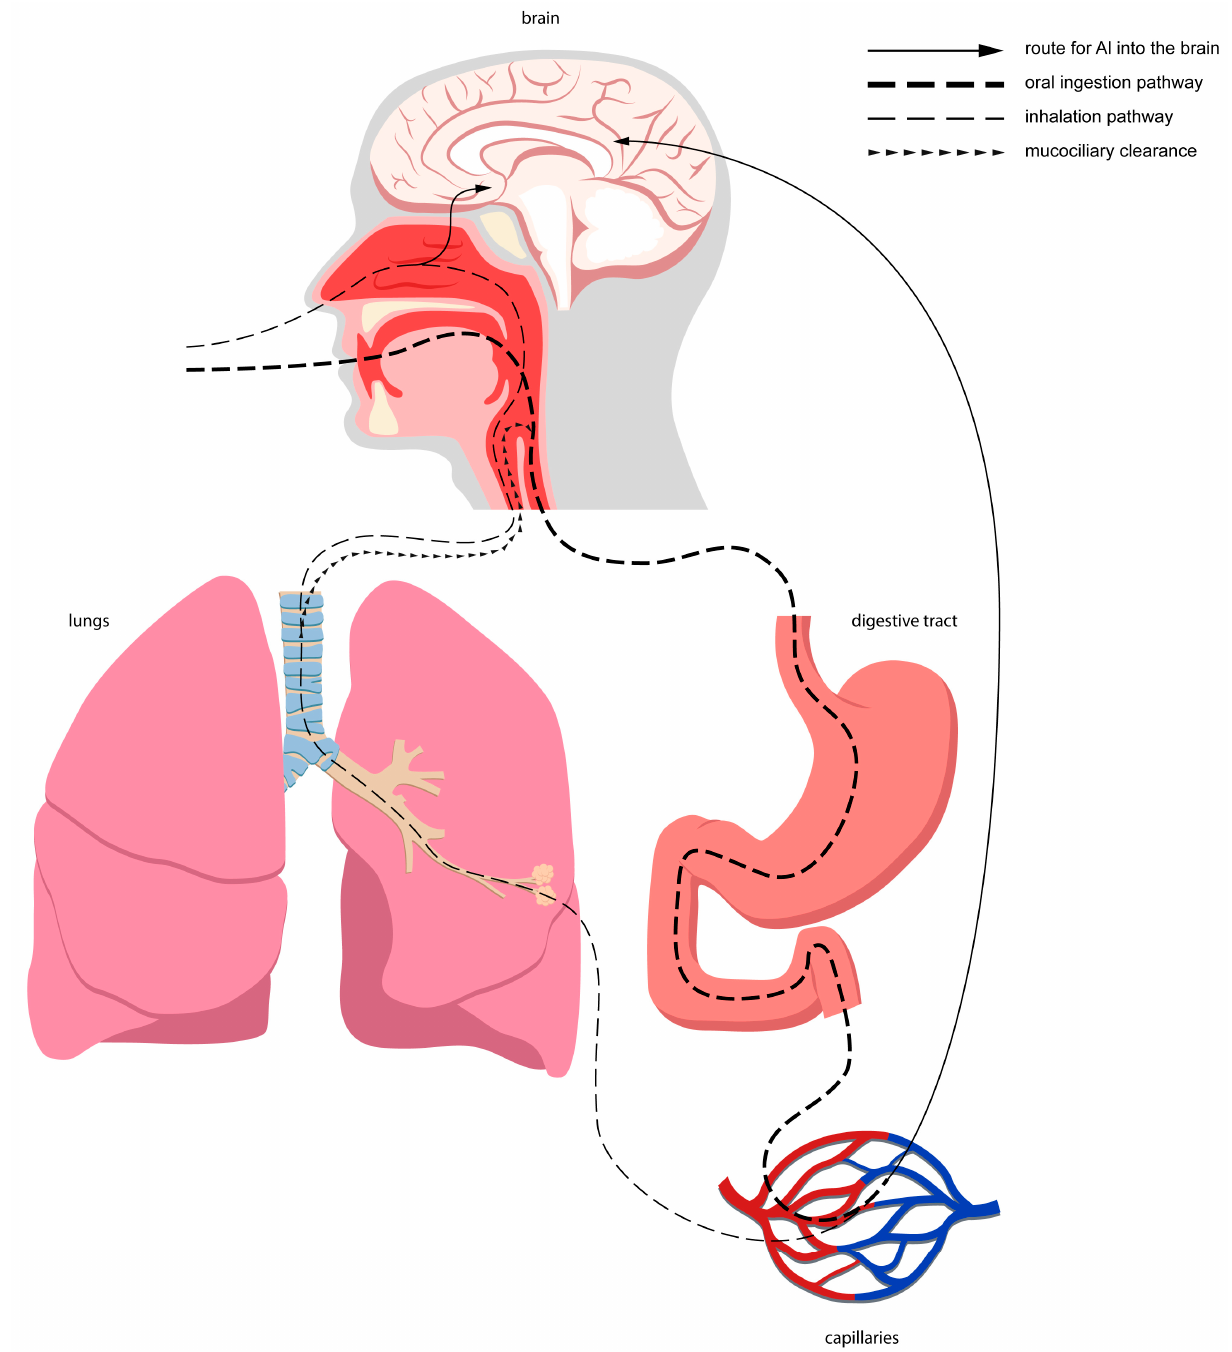
Figure 1. Main routes for Al into the brain. Red capillaries symbolize arterioles, while blue capilarries symbolize small veins.